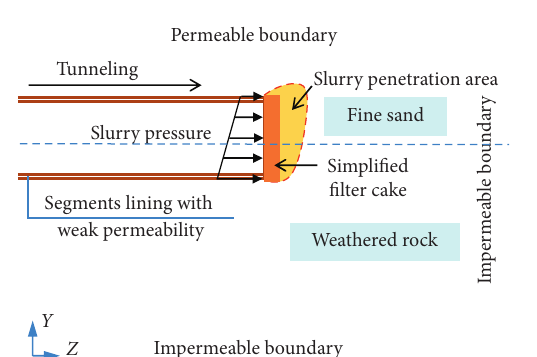
Figure 9: Boundary condition settings and construction process simulation. Figure 10: The longitudinal